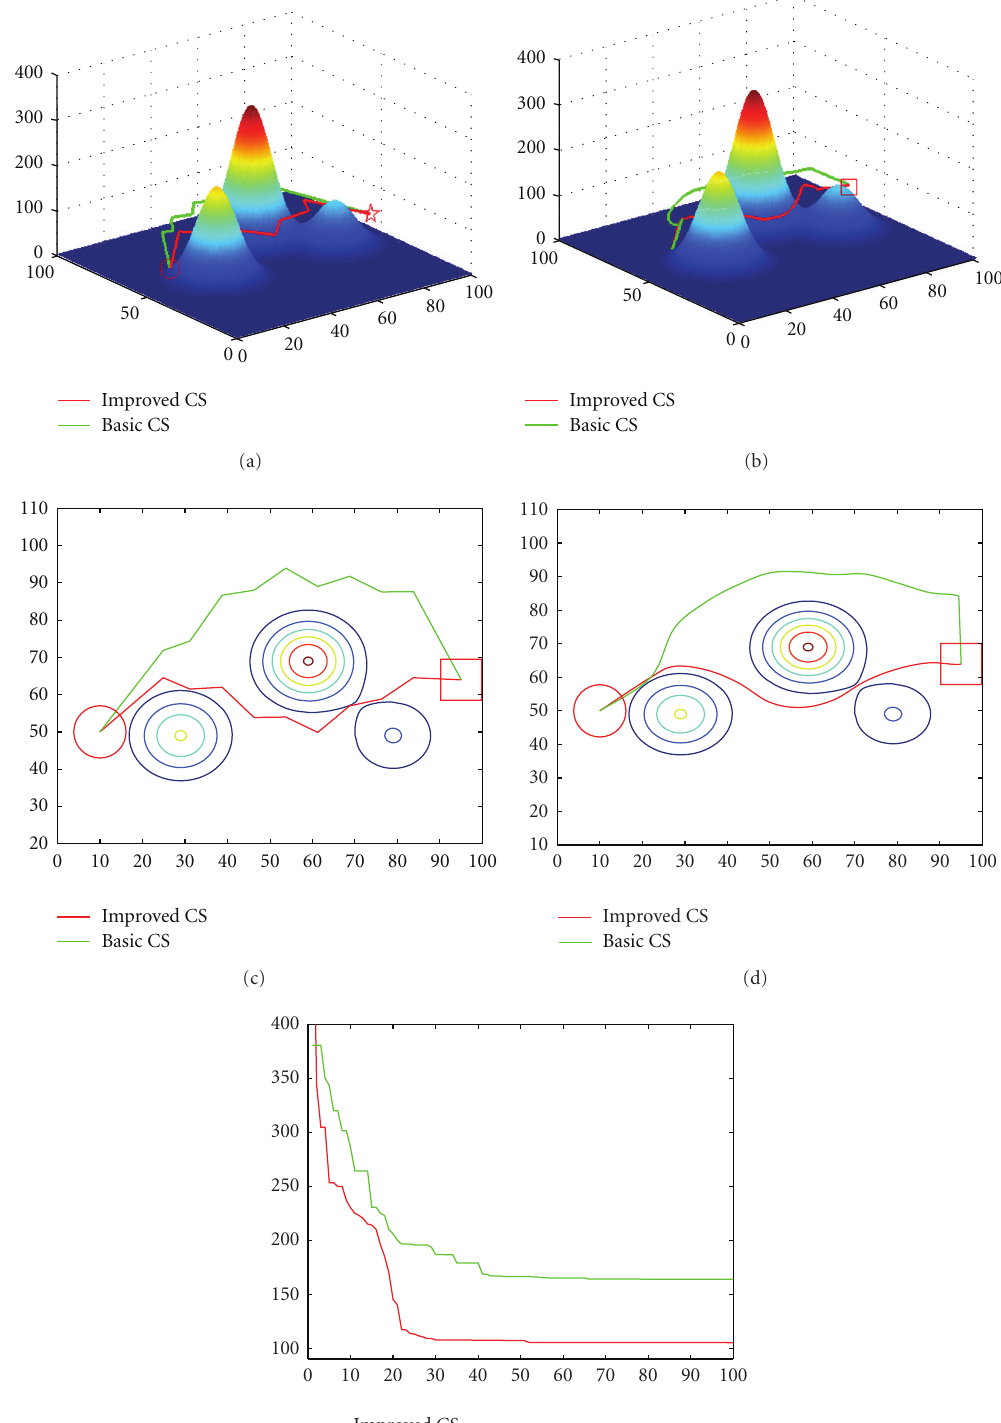
Figure 4: Parameter values were NP = 30, p a = 0.25. (a) Path-planning original results comparison between basic CS and improved CS in a three-dimension space. (b) Route comparison after using the smoothing strategy in a three-dimension space. (c) Path-planning original results comparison between basic CS and improved CS in a two-dimension space. (d) Route comparison after using the smoothing strategy in a two-dimension space. (e) Evolution curves comparison between the basic CS and the improved